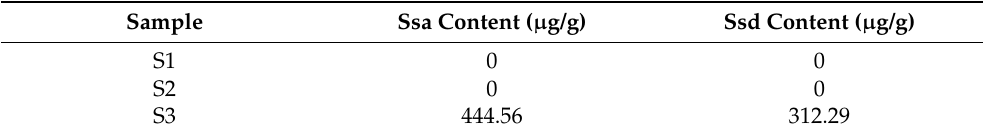
Table 1. Contents of SSa and SSd in the young root of